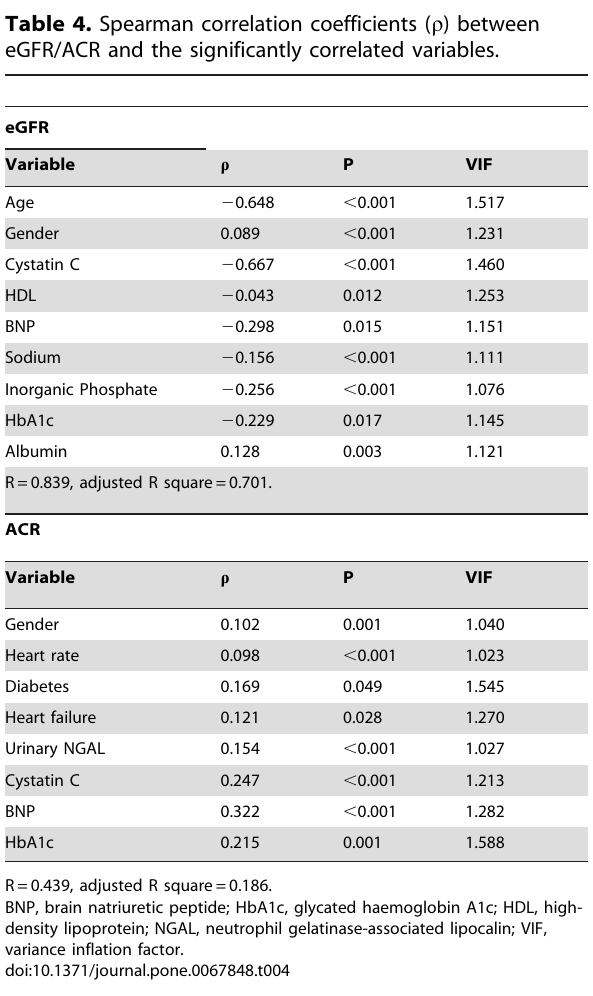
Table 5. Chronic kidney disease prevalence in primary care.